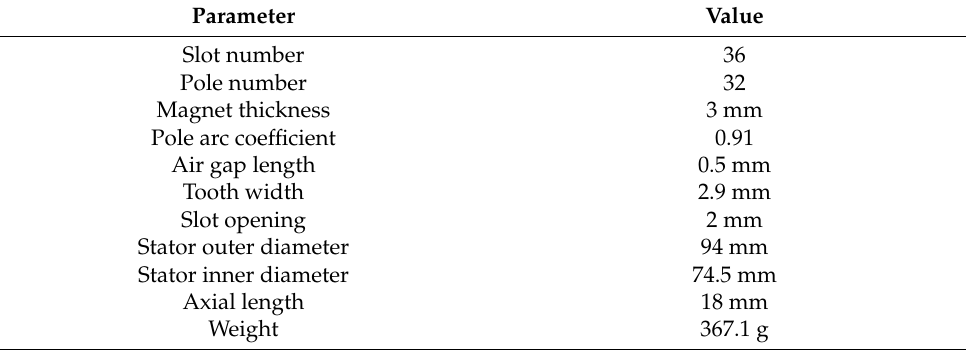
Table 4. The main parameters of the high overload motor.